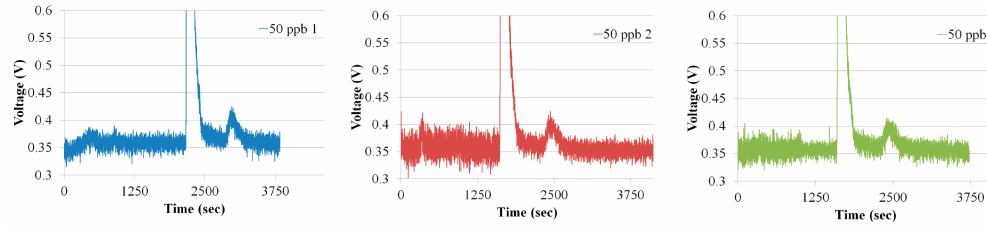
Figure 12. Three ethylene chromatograms at 50